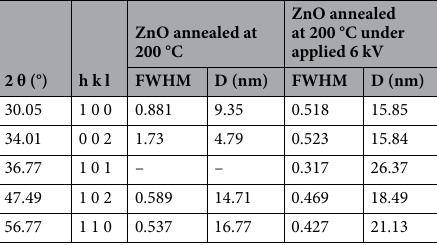
Table 1. The XRD parameters of the ZnO thin films.